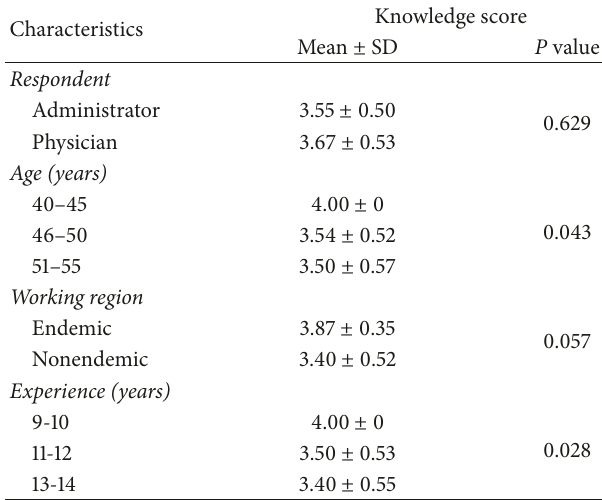
Table 3: Distribution and comparison of knowledge scores about access to care for Chagas disease according to demographic charac- teristics of the respondents ( 𝑛 = 16